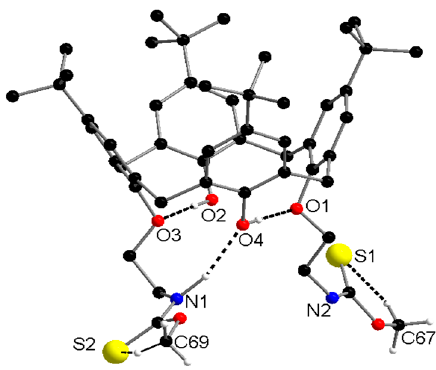
Figure 5. View of intramolecular interactions in compound ( 4 ). The H atoms not involved in the intermolecular interactions and the solvent methanol molecule have been omitted for clarity.